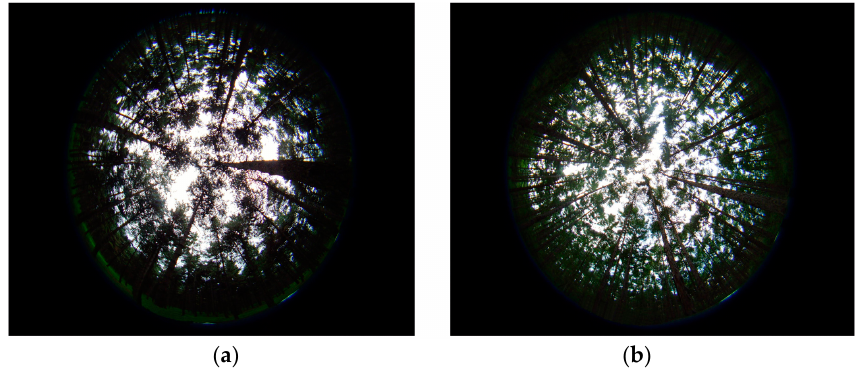
Figure 3. Examples of collected digital hemispherical photographs for: ( a ) Scotch pine; ( b ) Larch pine.